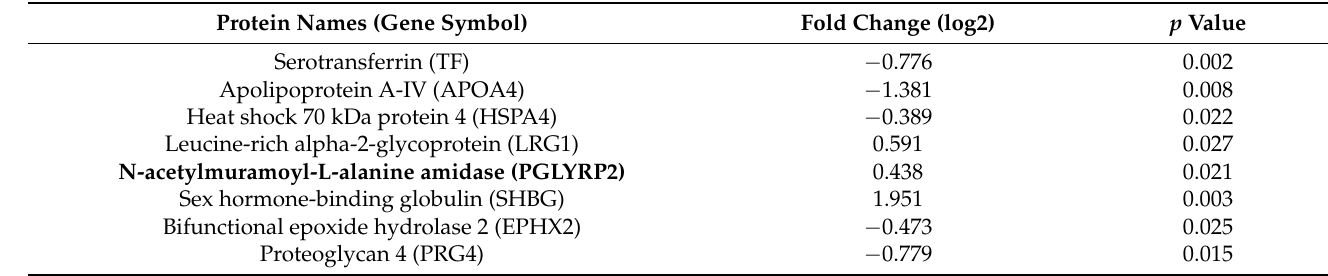
Table 4. Proteins showing a significant difference in expression at both 6- and 12-months post-surgery. Log fold changes are shown between baseline and 12